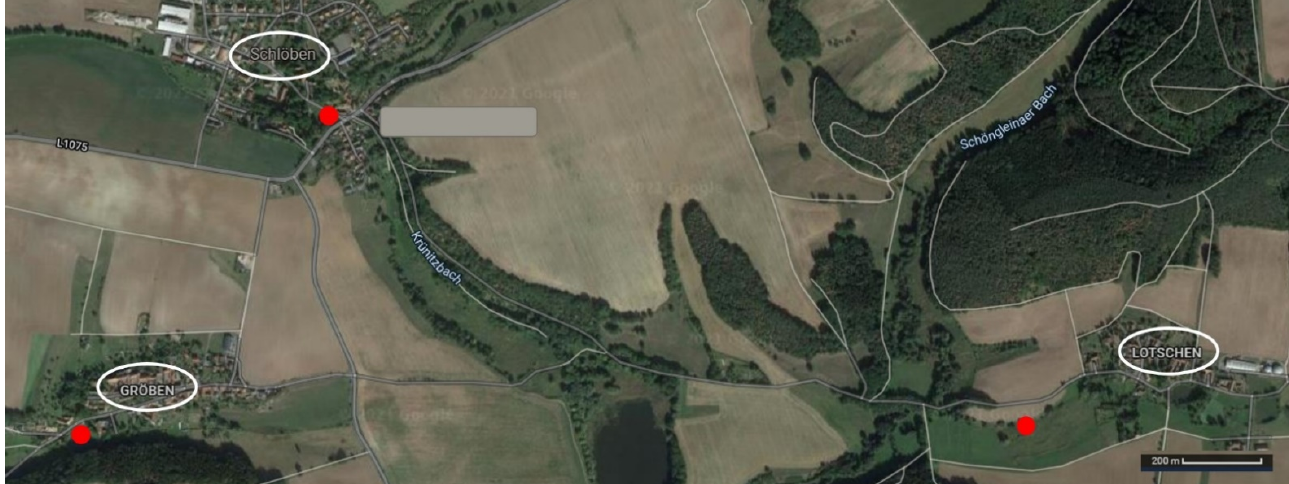
Figure 2. Map of the three closely located ponds in villages in Thuringia, Germany (Lotschen, Groeben, Schloeben), represented by red dots.